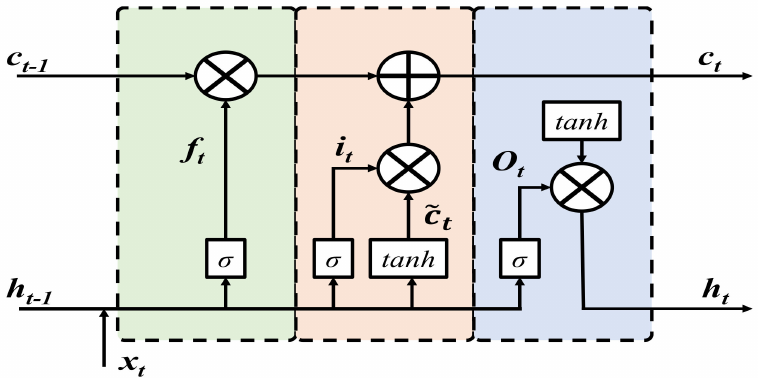
Figure 7. Architecture of